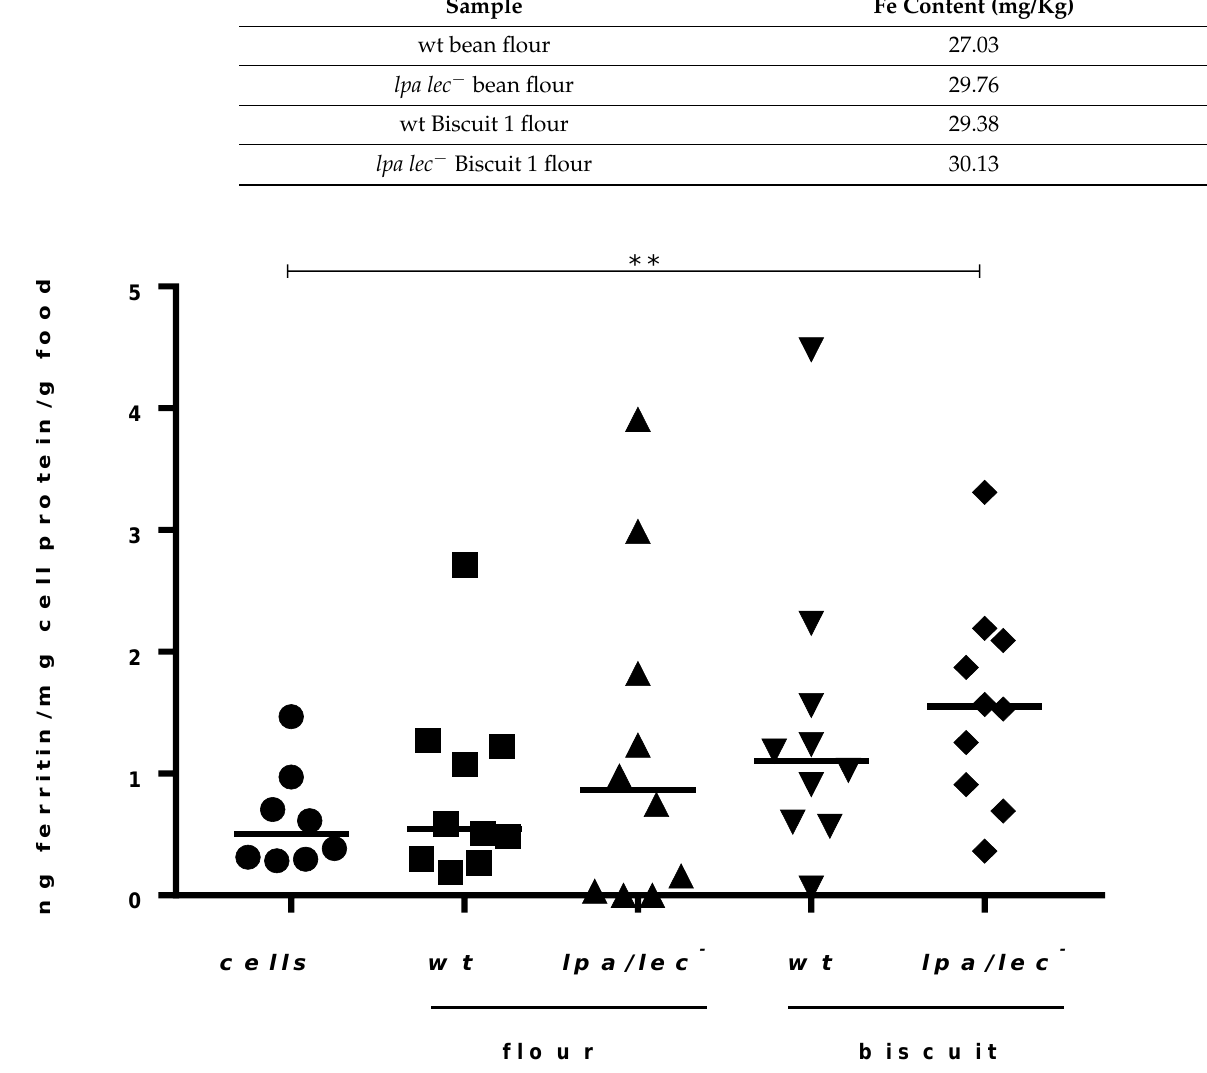
Figure 3. Ferritin production after incubation of Caco-2 cells with wild type (wt) flour, lpa lec − flour, wt Biscuit 1 or lpa lec − Biscuit1 samples. Samples (n = 10) were statistically evaluated by Mann-Witney test. ** p = 0.085.